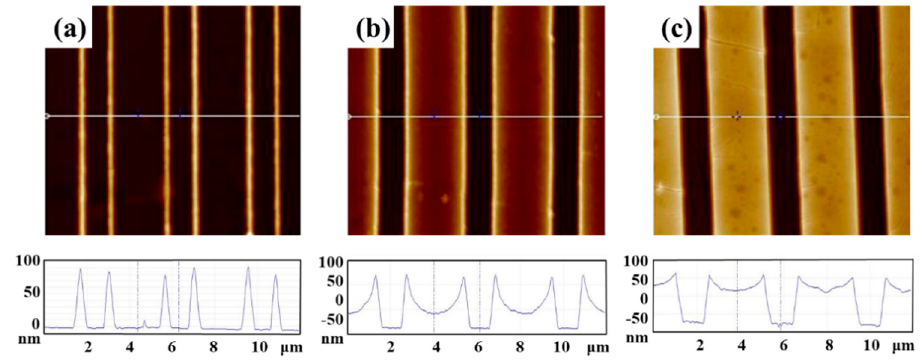
Figure 4. AFM images of PMMA/Ti 4+ lines obtained with different solution concentration: ( a ) 0.5%, ( b ) 1% and ( c ) 1.5%.